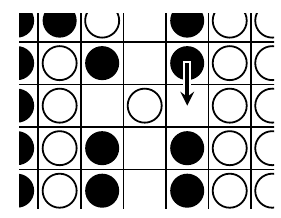
Figure 38. BLACK intrudes.